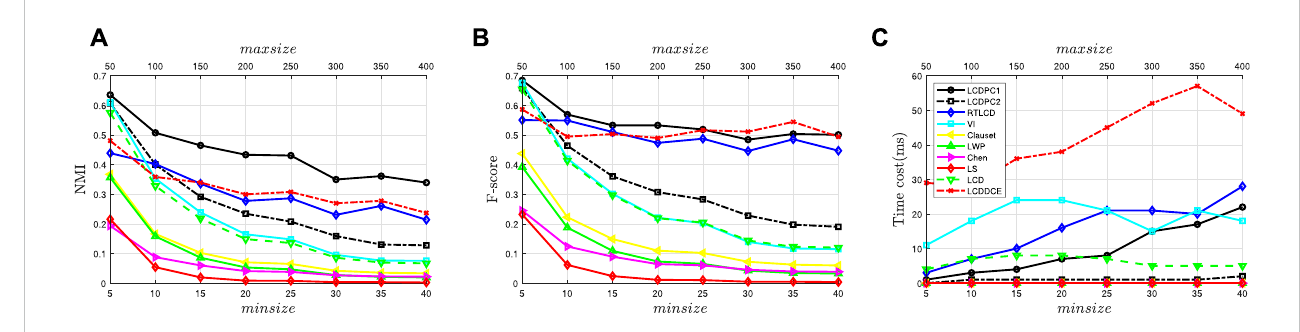
FIGURE 7 The performance of algorithms on LFR- α size . (A) NMI on LFR- α size . (B) F-measure on LFR- α size . (C) Time cost on LFR- α size .